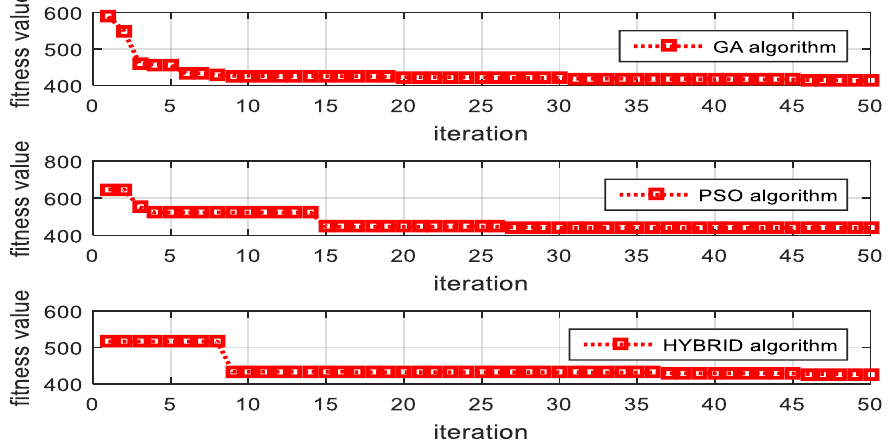
Figure 4. Variation of fitness function for GA, PSO, and hybrid-based optimization technique using PEM based technique for scenario-1.